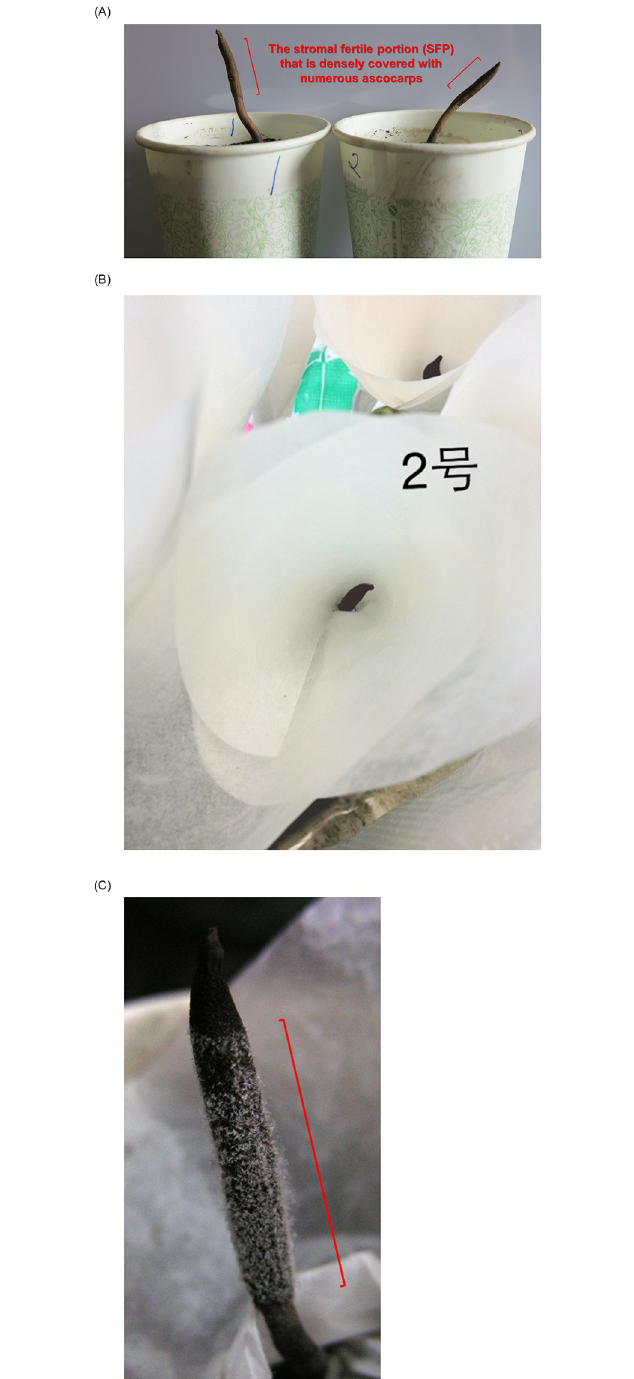
Fig 1. Cultivation of mature C . sinensis specimens in paper cups and collection of ascospores. Mature C . sinensis specimens were cultivated in our Xining laboratory (altitude of 2,200 m) (Fig 1A). The fully ejected ascospores were collected using the double layers of autoclaved weighing papers (Fig 1B). Numerous semiejected ascospores adhere to the outer surface of an ascus (Fig 1C, after removing the upper layer of autoclaved weighing papers for collection of the fully ejected ascospores) during the massive ejection of ascospores. The stromal fertile portion (SFP) densely covered with numerous ascocarps is labeled with “]”.